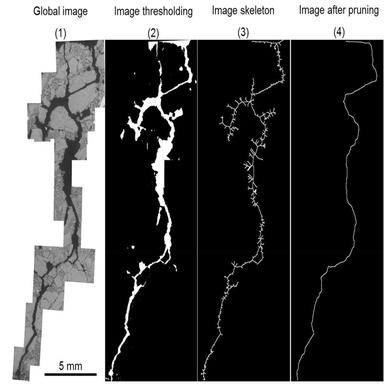
Global SEM image analysis steps to extract the main crack path.